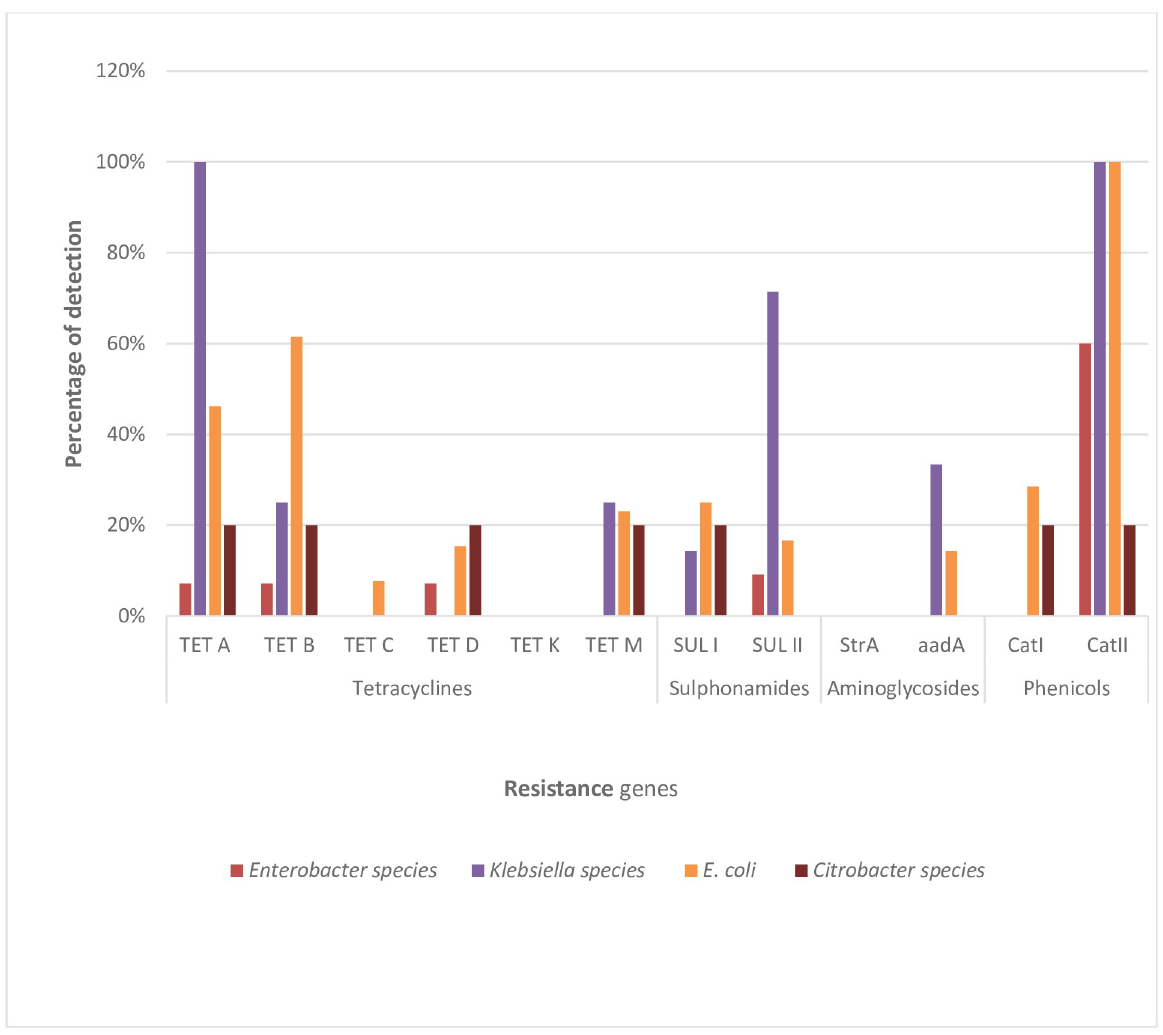
Fig 7. The prevalence of key non- β -lactamase resistance genes detected across the bacterial isolates. These include the genes coding for resistance against antibiotic classes tetracycline, sulphonamide, aminoglycoside, and phenicol. For tetracyclines, sulphonamides, aminoglycosides, and phenicols: Enterobacter spp. (n = 14, 11, 11 and 10 respectively), Klebsiella spp. (n = 4, 7, 3 and 3 respectively), E . coli (n = 13, 12, 7 and 7 respectively); Citrobacter spp. (n = 5, 5, 3 and 5 respectively) where n is the number of phenotypically resistant isolates screened for representative antibiotic resistance